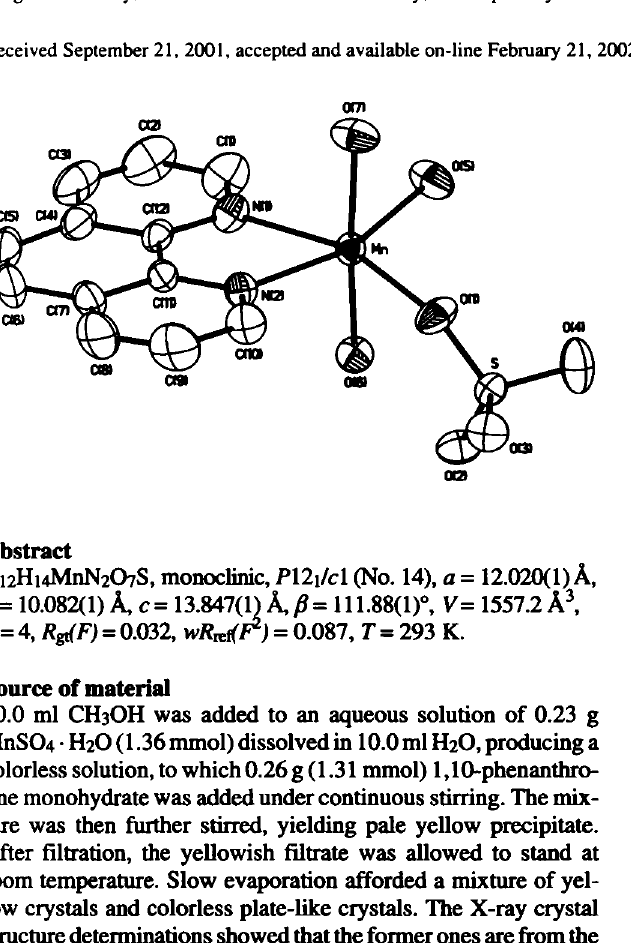
Table 2. Atomic coordinates and displacement parameters (in Â 2